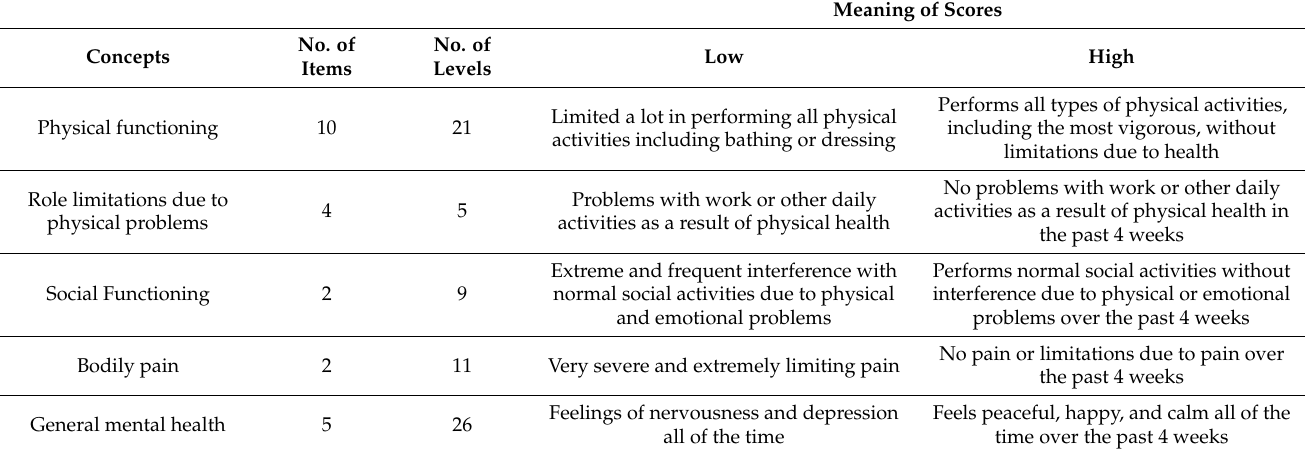
Table 1. Information About SF-36 Health Status Scales and the Interpretation of Low and High Scores